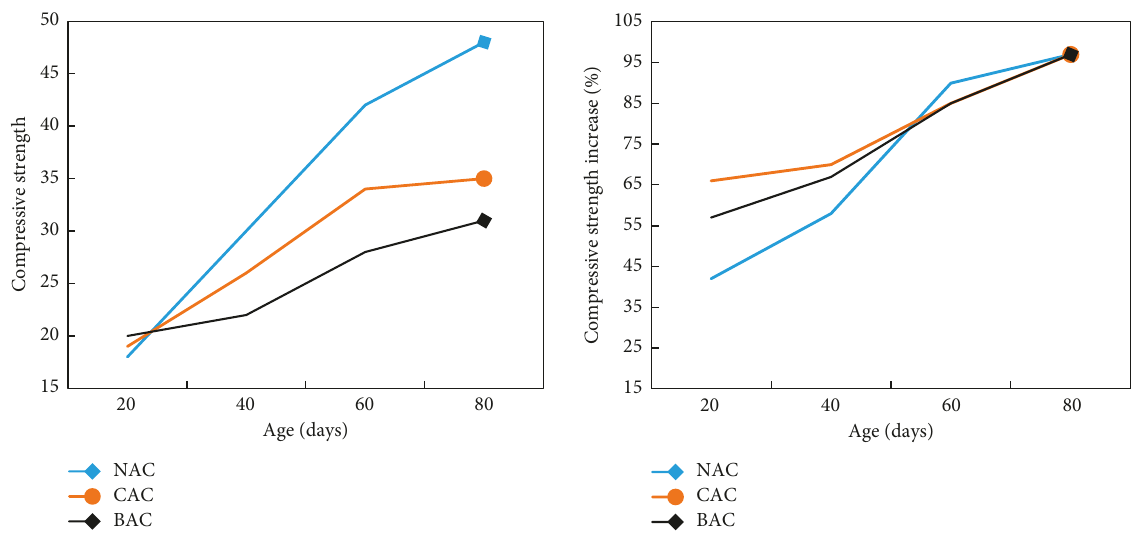
Figure 3: Compressive strength of concrete